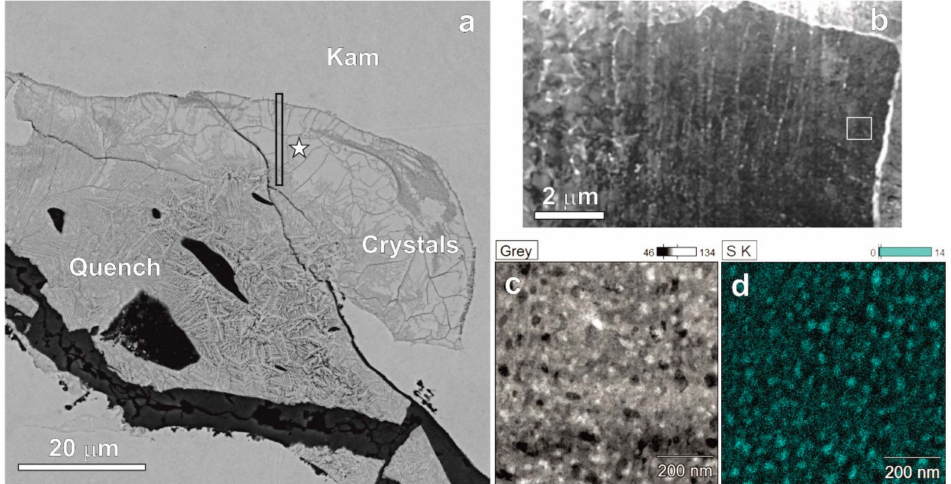
Figure 4. Crystal-like FN3 aggregate with average composition (Fe 2.45 Ni 0.52 Co 0.02 ) 2.99 (P 0.73 S 0.28 ) 1.01 ( a ) coexisting with quenched oxidized FN3 aggregates (Site 13 in Table S1). Star shows position of EBSD pattern. Bar shows location of focused ion beam film presented in ( b ). ( c ) and ( d ) secondary electron image and elemental map for sulfur in the area shown by square in ( b ). ( b – d ) are based on our preliminary transmission electron microscope